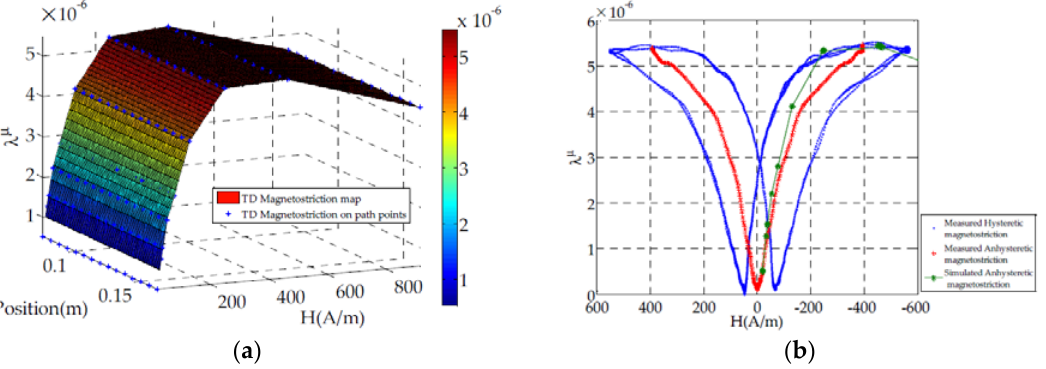
Figure 10. Comparison between measured and simulated magnetostriction along the TD column. ( a ) on path (Figure 9); ( b ) at TD-column middle (Figure 9).